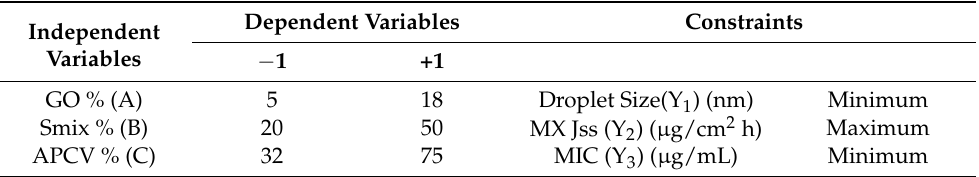
Table 1. Experimental plan for MX-loaded GO-APCV nanoemulsion.